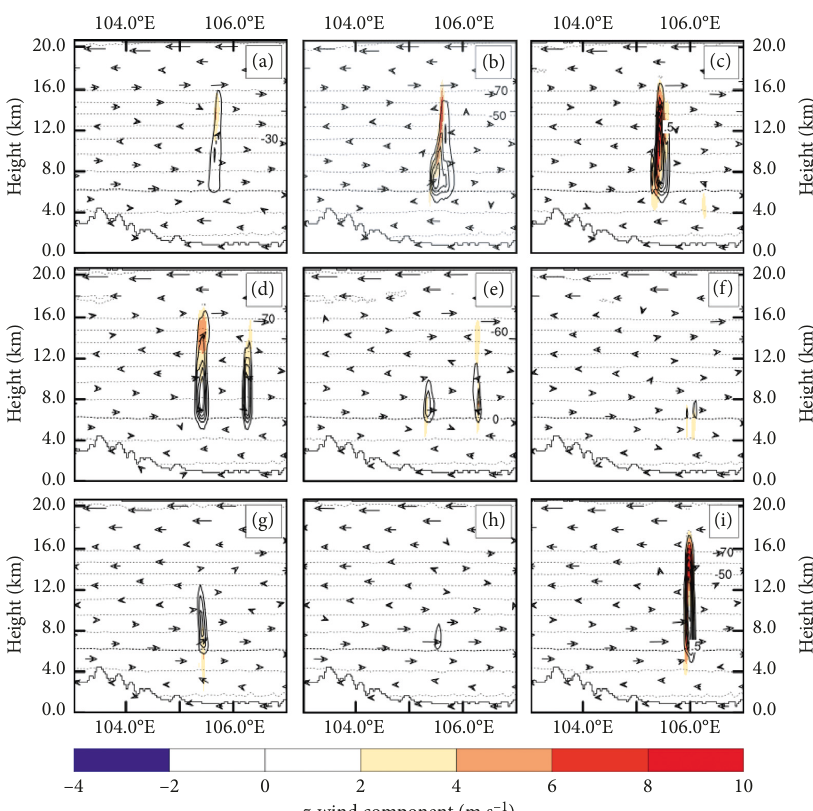
Figure 10: Longitude-height cross section of graupel mixing ratio at 32.1 ° N; the mixing ratio of graupel is represented by solid lines (start value: 0.5 g/kg; interval: 1 g/kg); the updraft velocity is represented by shaded color; the thick dotted line is the 0 ° C isotherm on June 27: (a) 13:30; (b) 14:00; (c) 15:00; (d) 15:30; (e) 16:00; (f) 18:00; (g) 19:00; (h) 20:00; (i) 21:00.